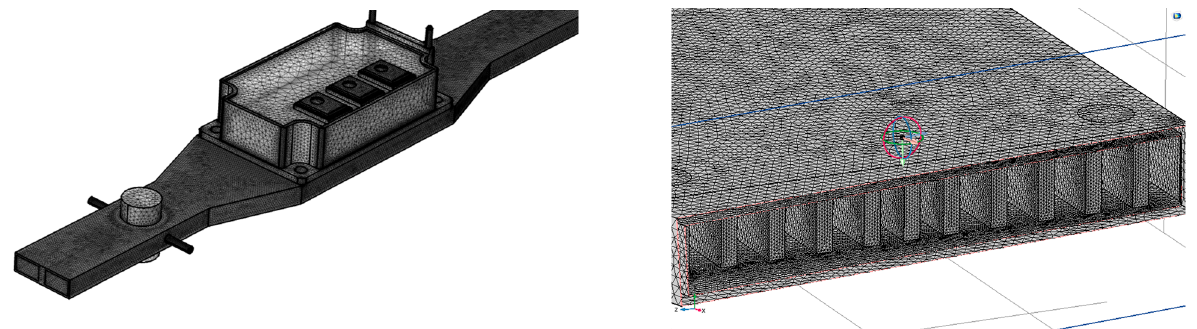
Figure 4. Adopted meshing configuration for computational domain with cooling